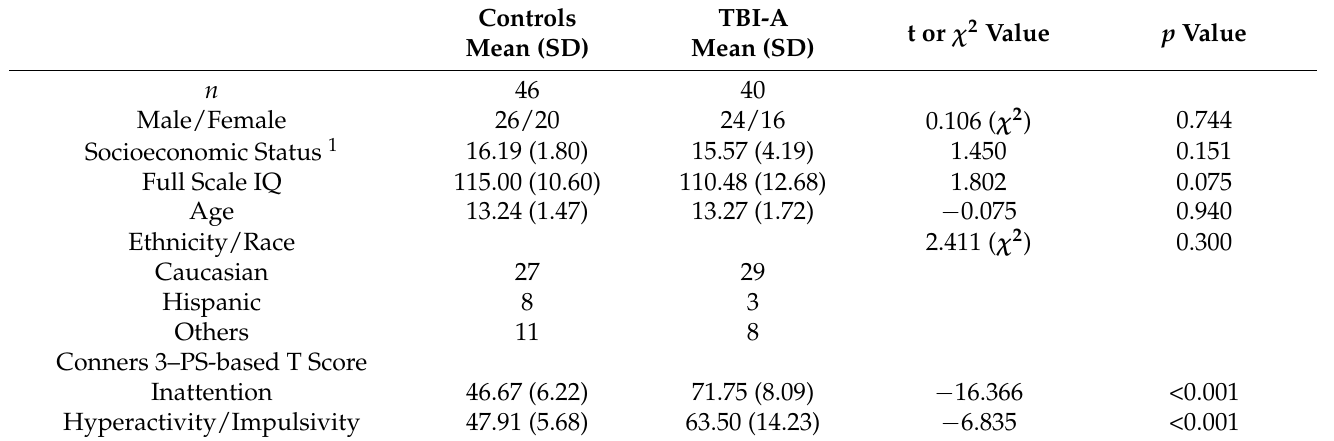
Table 1. Demographic and clinical characteristics of the study